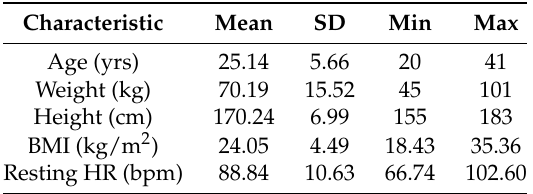
Table 1. Demographic data for the participants in this